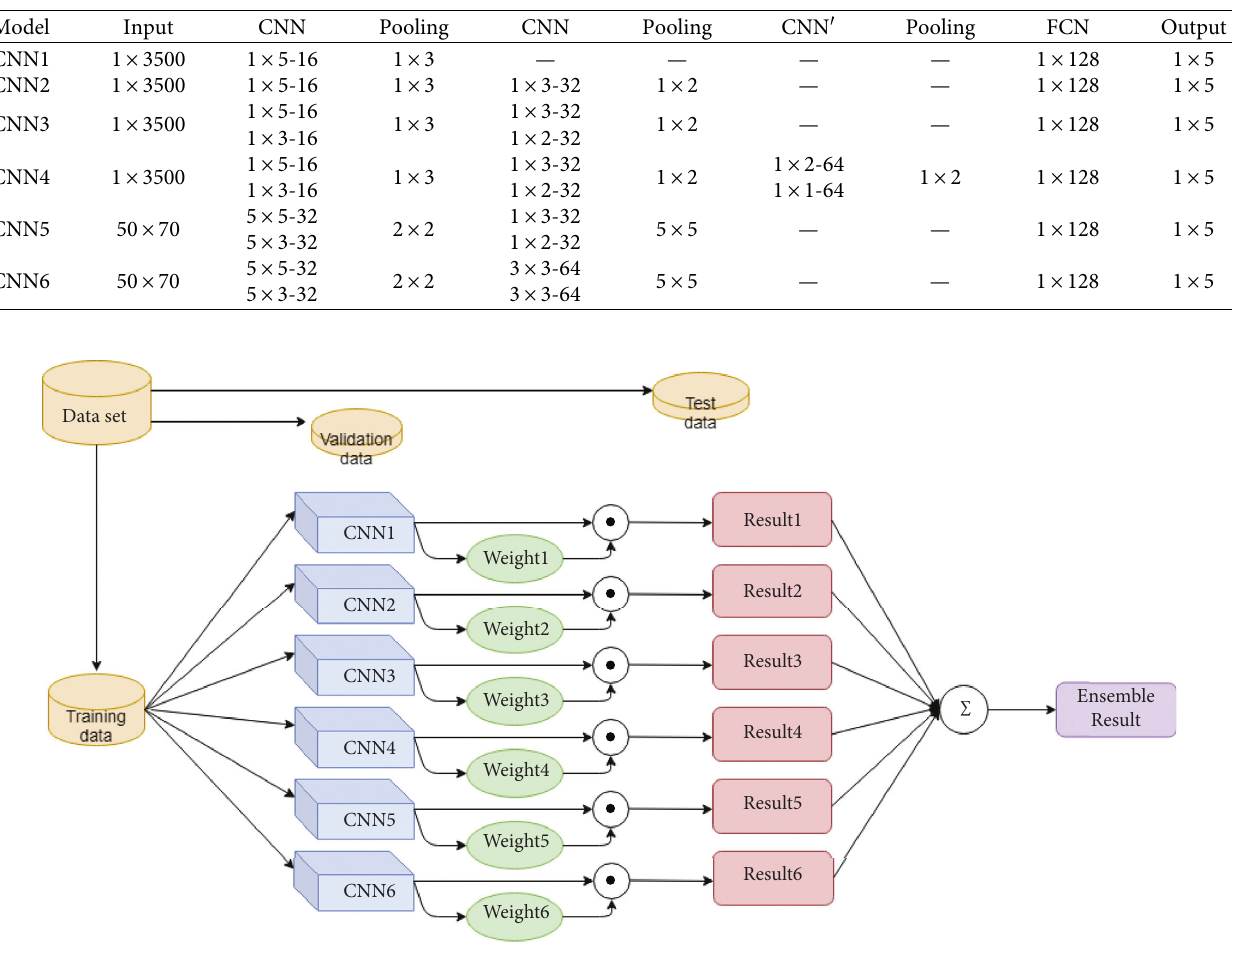
Figure 3: Spectral subclass and SNR